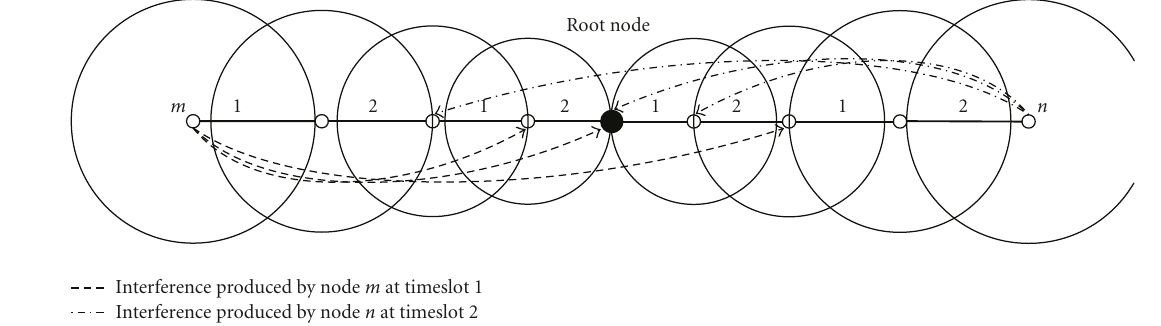
Figure 2: Best-case scenario for timeslot reuse: the number of required timeslots is equal to